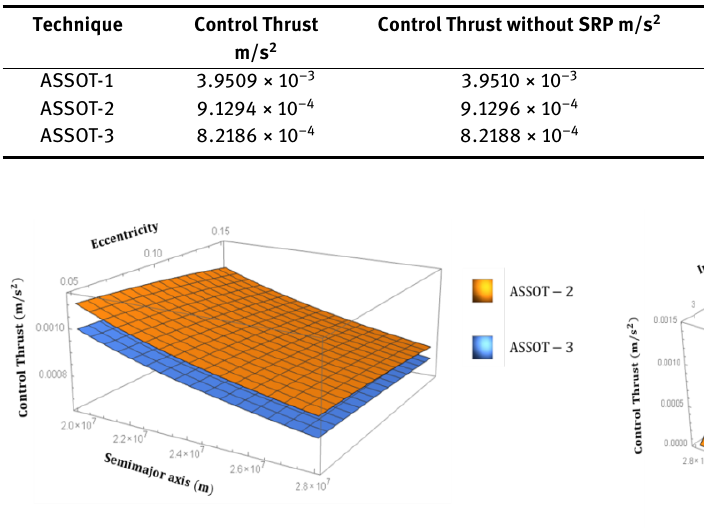
Figure 5. Control thrust vs. semimajor axis and eccentricity for ASSOT-2 and ASSOT-3